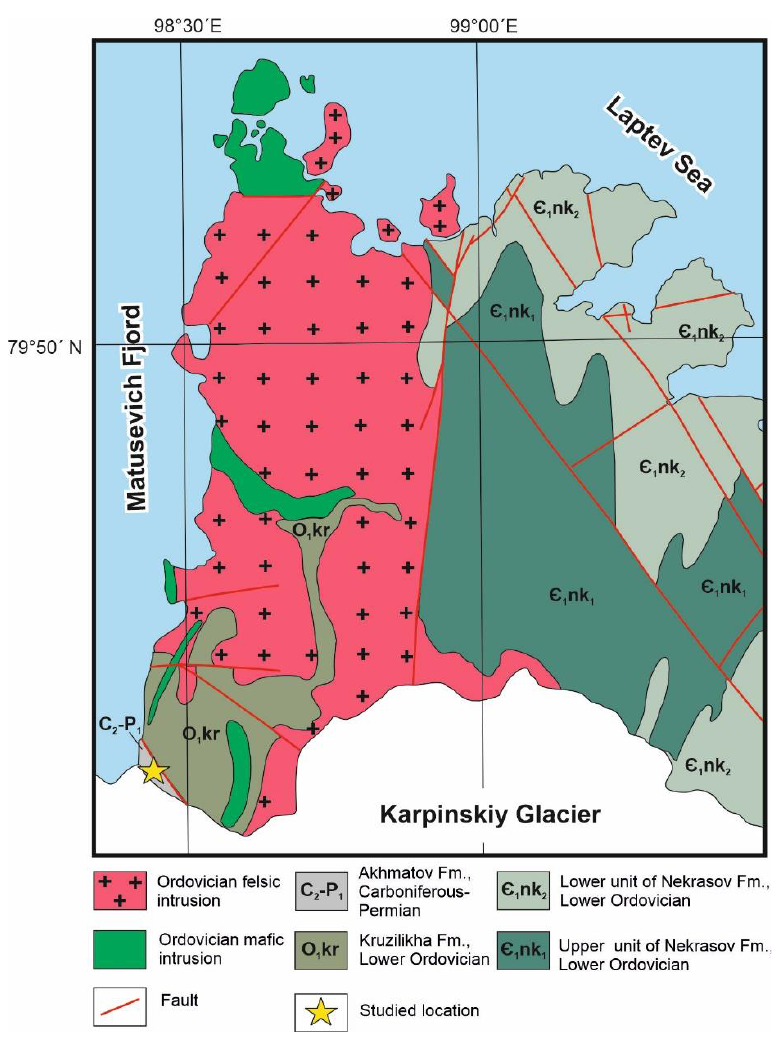
Figure 3. Geological map of the study area and location of samples (modified after [14,17]). Samples were collected from exposures along the south-eastern coast of Matusevich Fjord (Figure 3), where two rock units of contrasting ages and structural styles crop out. Lower Ordovician volcaniclastic deposits form a steeply dipping monocline, com- prising tuffaceous mudstones and siltstones with subordinate interlayers of felsic tuffs, mafic tuffs, and volcanic rocks (Figure 4). Tuffaceous mudstones and siltstones are cherry and bright green in color, medium-platy and massive, with individual beds attaining a thickness of 0.2–1.5 m. Interlayers of pinkish-beige tuffs and rhyolites occur, which attain thicknesses of up to 0.7 m. Subordinate beds of dark gray-green and bright green andesite ranging from 0.2–0.8 m in thickness have also been reported. Several hundred meters of Lower Ordovician rocks are exposed under the edge of the Karpinskiy